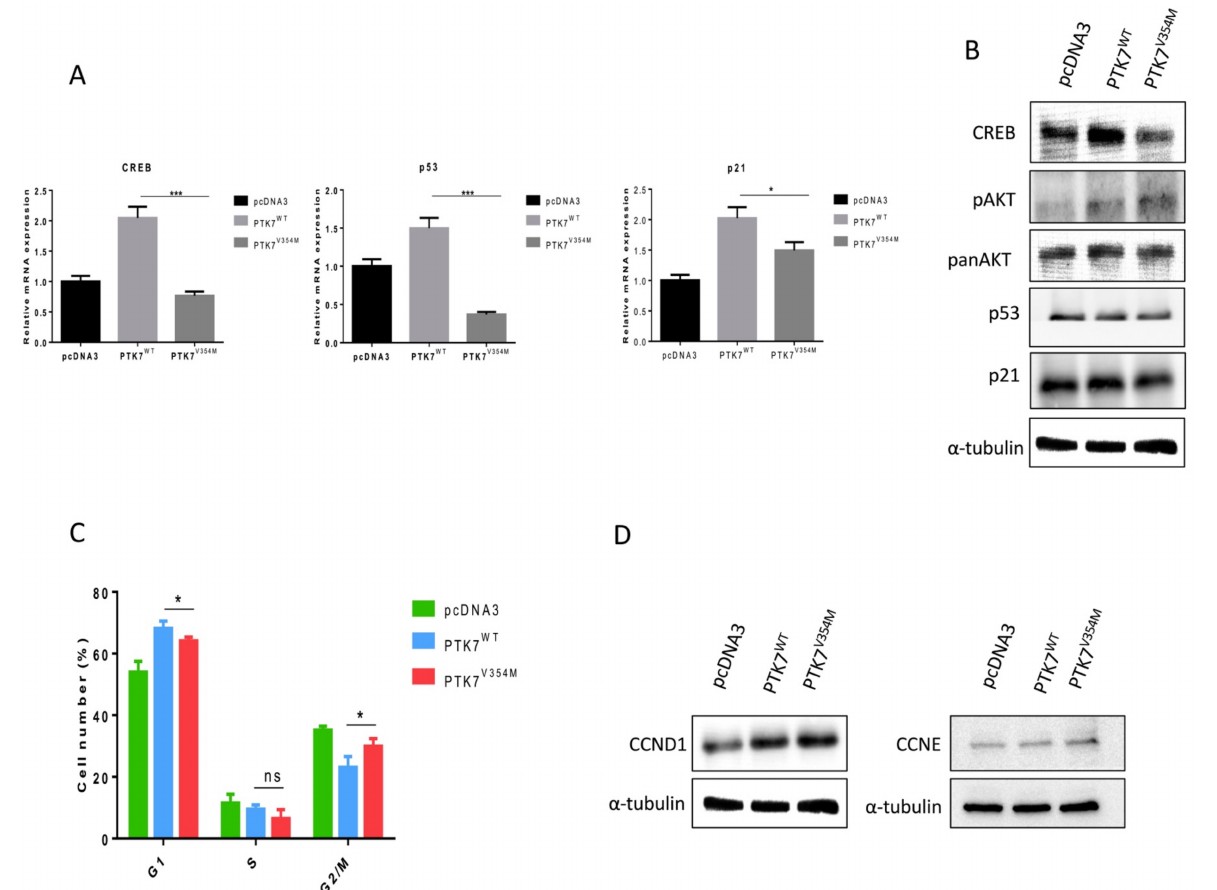
Figure 4. Effect of PTK7 V354M variant on downstream targets and cell cycle. ( A ) qPCR resulted in significant down-regulation of p53, p21 , and CREB mRNA levels in HT29- PTK7 V354M cells. * p < 0.05, *** p < 0.01. ( B ) Western blot results representing enhanced protein expression of pAKT as well as decreased CREB, p53 and p21 protein expression in HT29- PTK7 V354M cells compared to HT29- PTK7 WT cells. ( C ) HT29-PTK7 V354M transfected cells resulted in significant cell cycle progression with less accumulation of cells in the G0/G1 phase compared to HT29- PTK7 WT cells and a concomitant increase in G2/M phase, confirming the cell proliferation results. ns—no significance, * p < 0.05. ( D ) HT29-PTK7 V354M transfected cells showed upregulated CCND1 and CCNE protein expression, involved in cell cycle regulation. PTK7 V354M –PTK7 plasmid with the mutation V354M, PTK7 WT –wild type PTK7 plasmid, pcDNA3–control vector